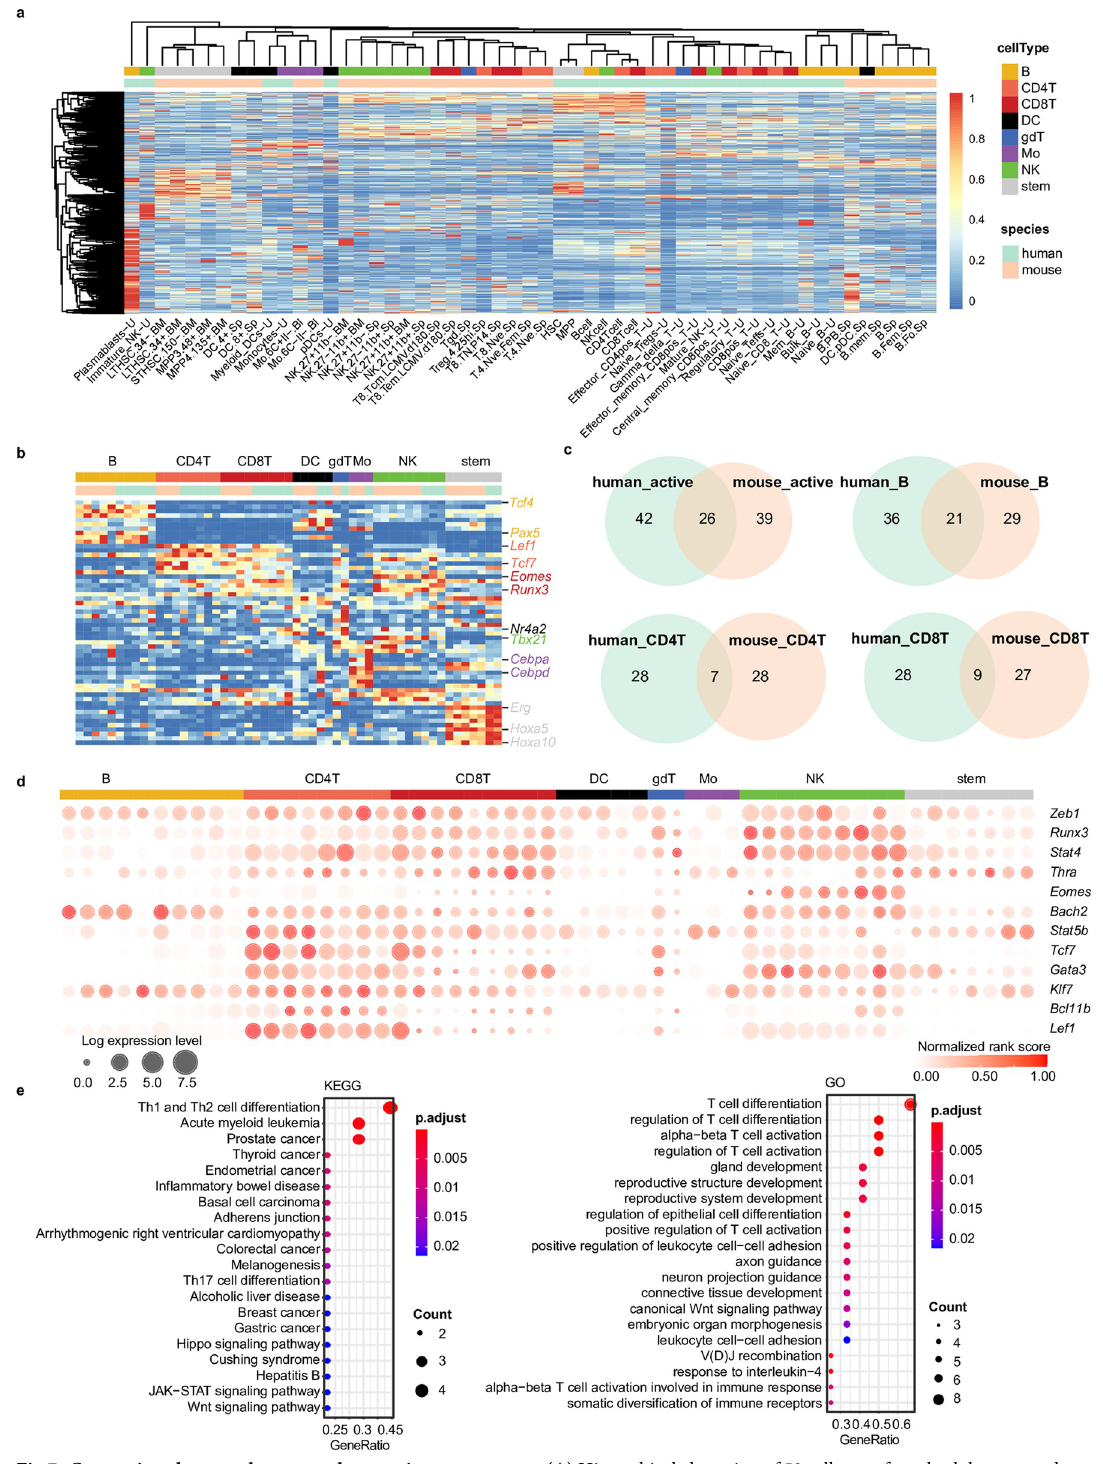
Fig 7. Comparison between human and mouse immune system. (A) Hierarchical clustering of 53 cell types from both human and mouse systems based on row-wise normalized PageRank scores of 733 TFs. TFs in rows, cell types in columns, and color of the cell in the matrix indicate the normalized PageRank scores with red displaying high scores. (B) PageRank scores heatmap of top10 cell lineage- specific TFs. Selected gene names are colored based on their cell lineage specificity. Legends and columns are the same as in (A) . (C) Comparison of active TFs and 3 comparisons of specific TFs between human and mouse systems. “Active” means the